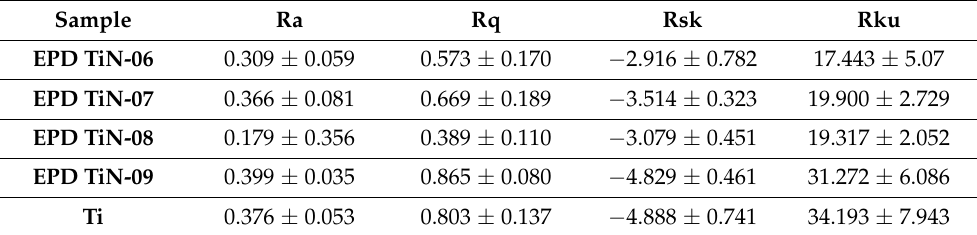
Table 3. Surface roughness parameters obtained from line profiles for Ti polished and infil- trated